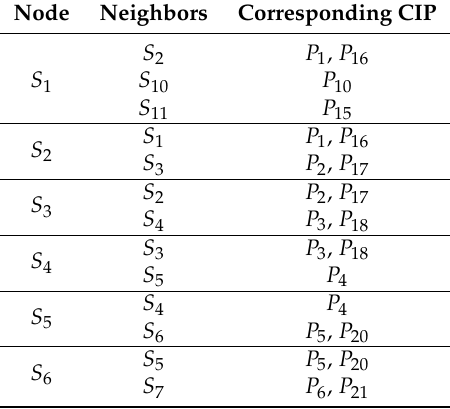
Table 1. List of neighbors and corresponding critical intersection points (CIP) of a